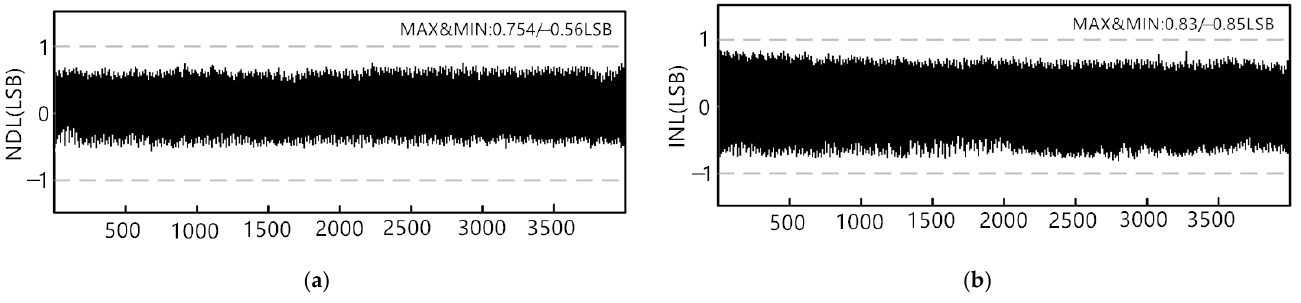
Figure 24. Measured DNL ( a ) and INL ( b ) when the proposed calibration method was on.